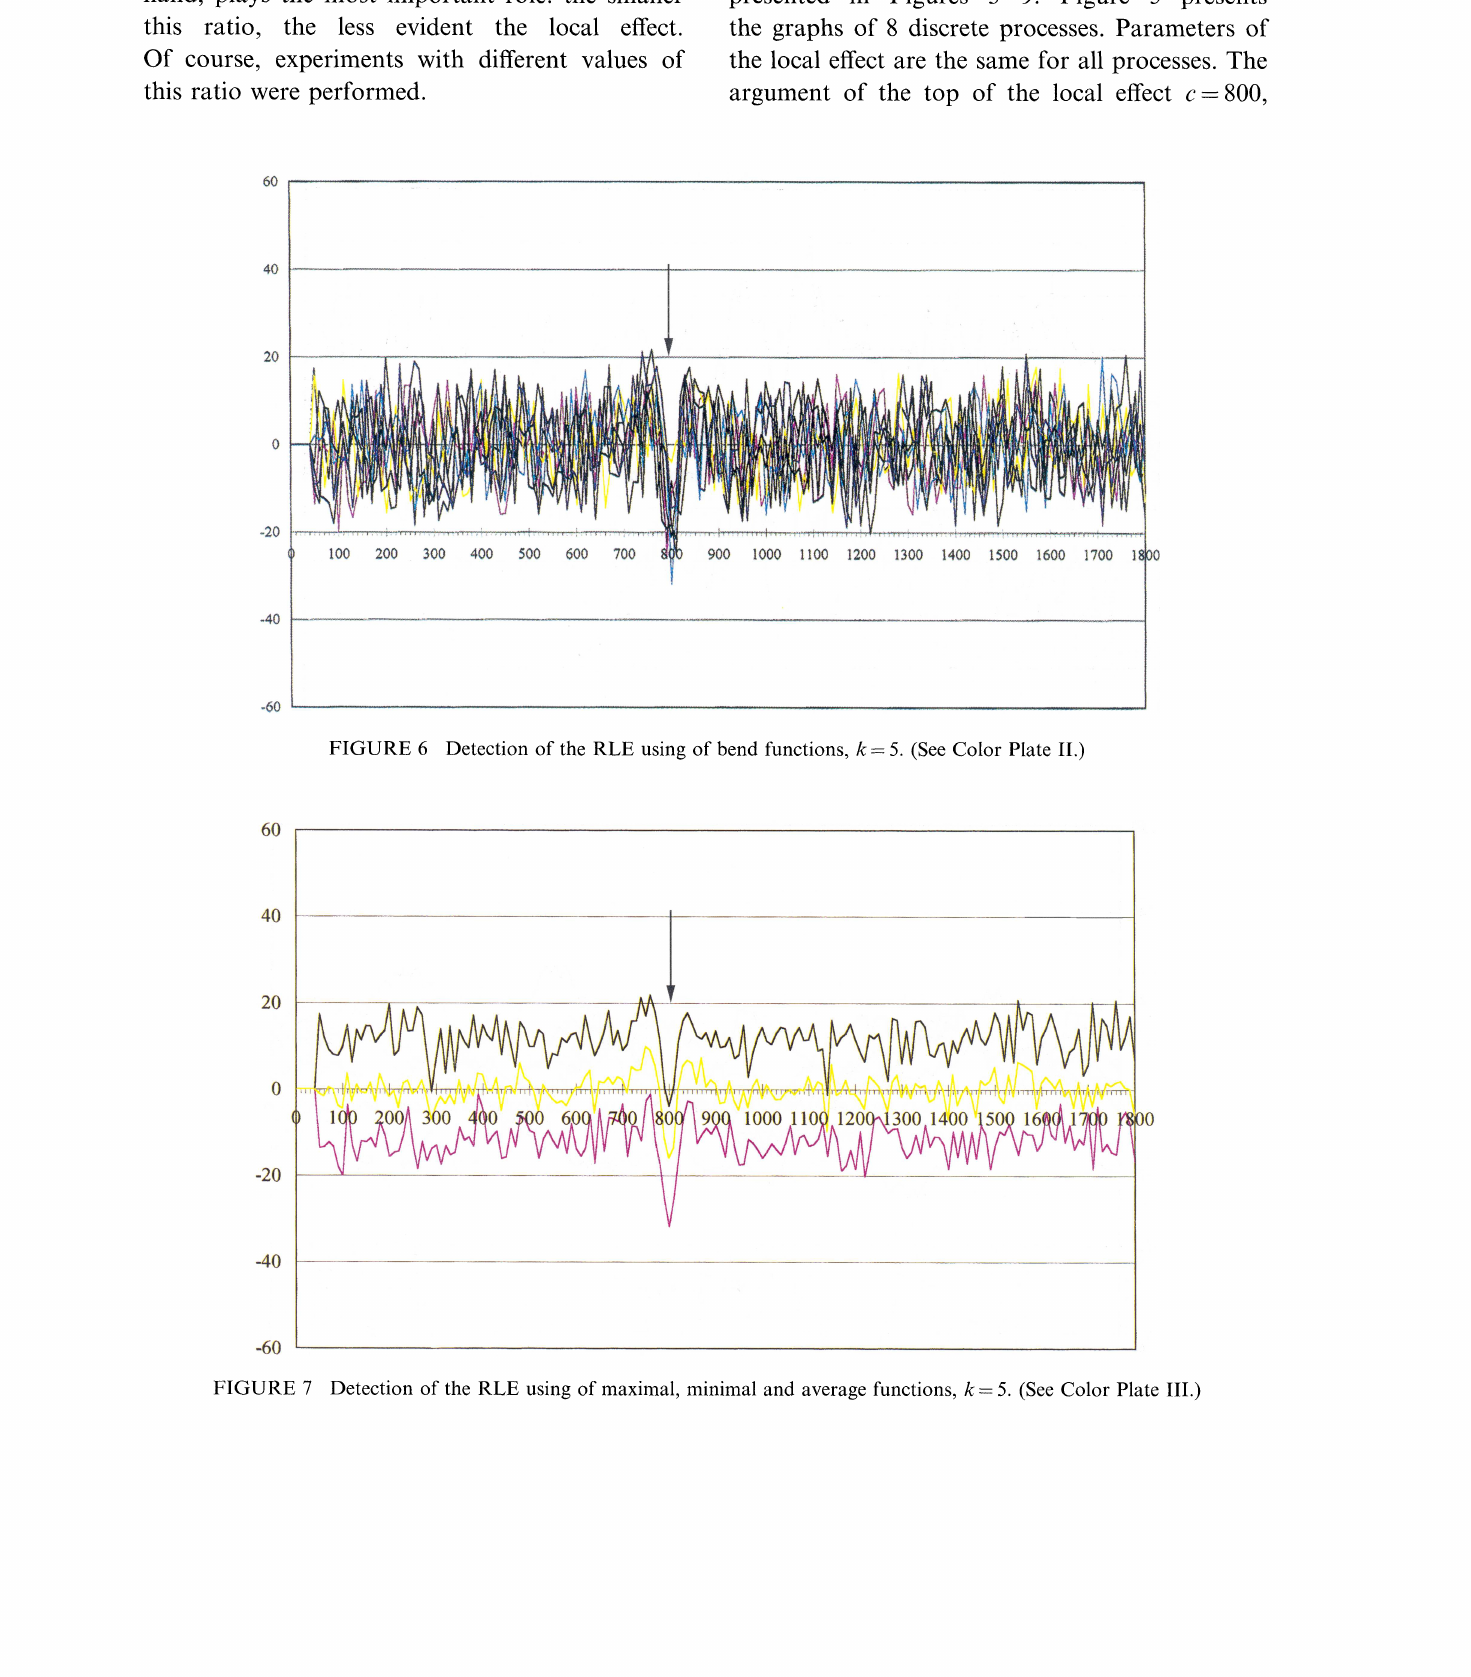
FIGURE 6 Detection of the RLE using of bend functions, k 5. (See Color Plate II.)